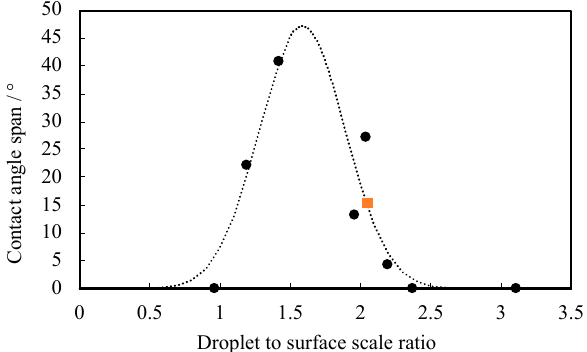
Figure 8. Contact angle distribution as a function of the droplet to surface scale ratio. The results correspond to eight surfaces of various sinusoidal wavelengths, which are plotted with black dots. The span over the surface with Ketton roughness is shown in the orange square. These data points are fit to a Gaussian function (dashed lines), which is drawn as a guide to the eye.